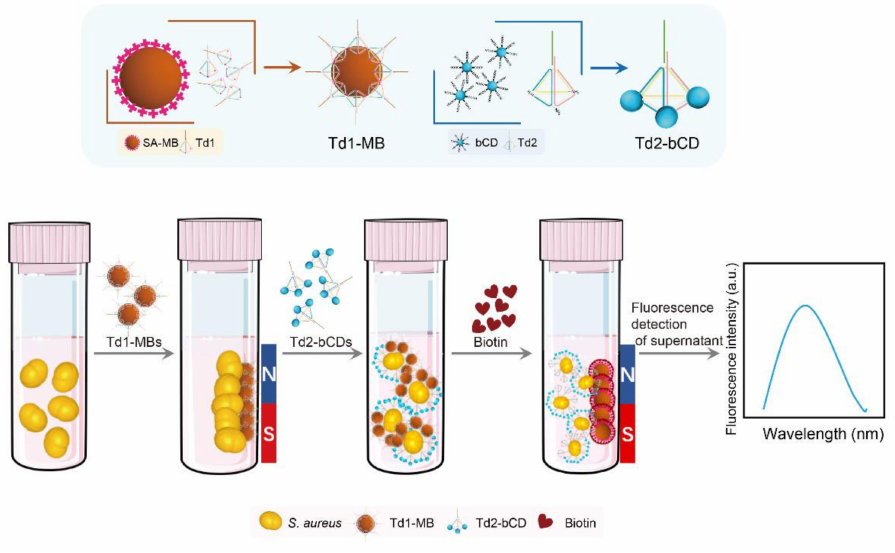
Scheme 1. Schematic of experimental